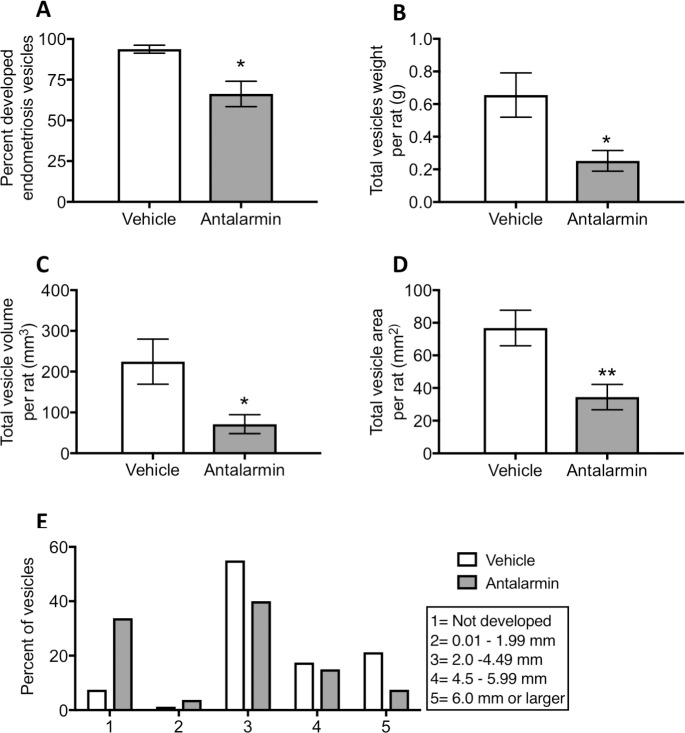
Morphological characteristics of endometriosis vesicles.(A) The percent of implants that developed into vesicles was significantly lower in the antalarmin treated group (n = 20) compared to the vehicle control group (n = 20). (B) The total weight of all vesicles per rat was smaller for the antalarmin treated rats. (C) The average vesicle volume per rat was significantly smaller for the antalarmin treated group compared to the vehicle control group. (D) The average vesicle area per rat was significantly smaller in the antalarmin group compared to the vehicle group. (E) Vesicles that developed were classified by grade based on a scale by size showing that the individual vesicles in the antalarmin treated group tended to be smaller (grade 2) or not develop at all (grade 1). * p< 0.05, ** p< 0.01.